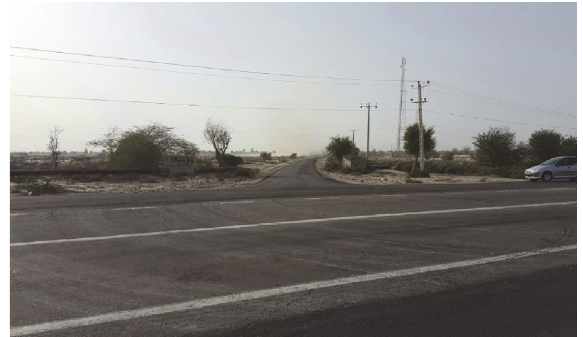
Figure 4: Section 7: Nobandian.